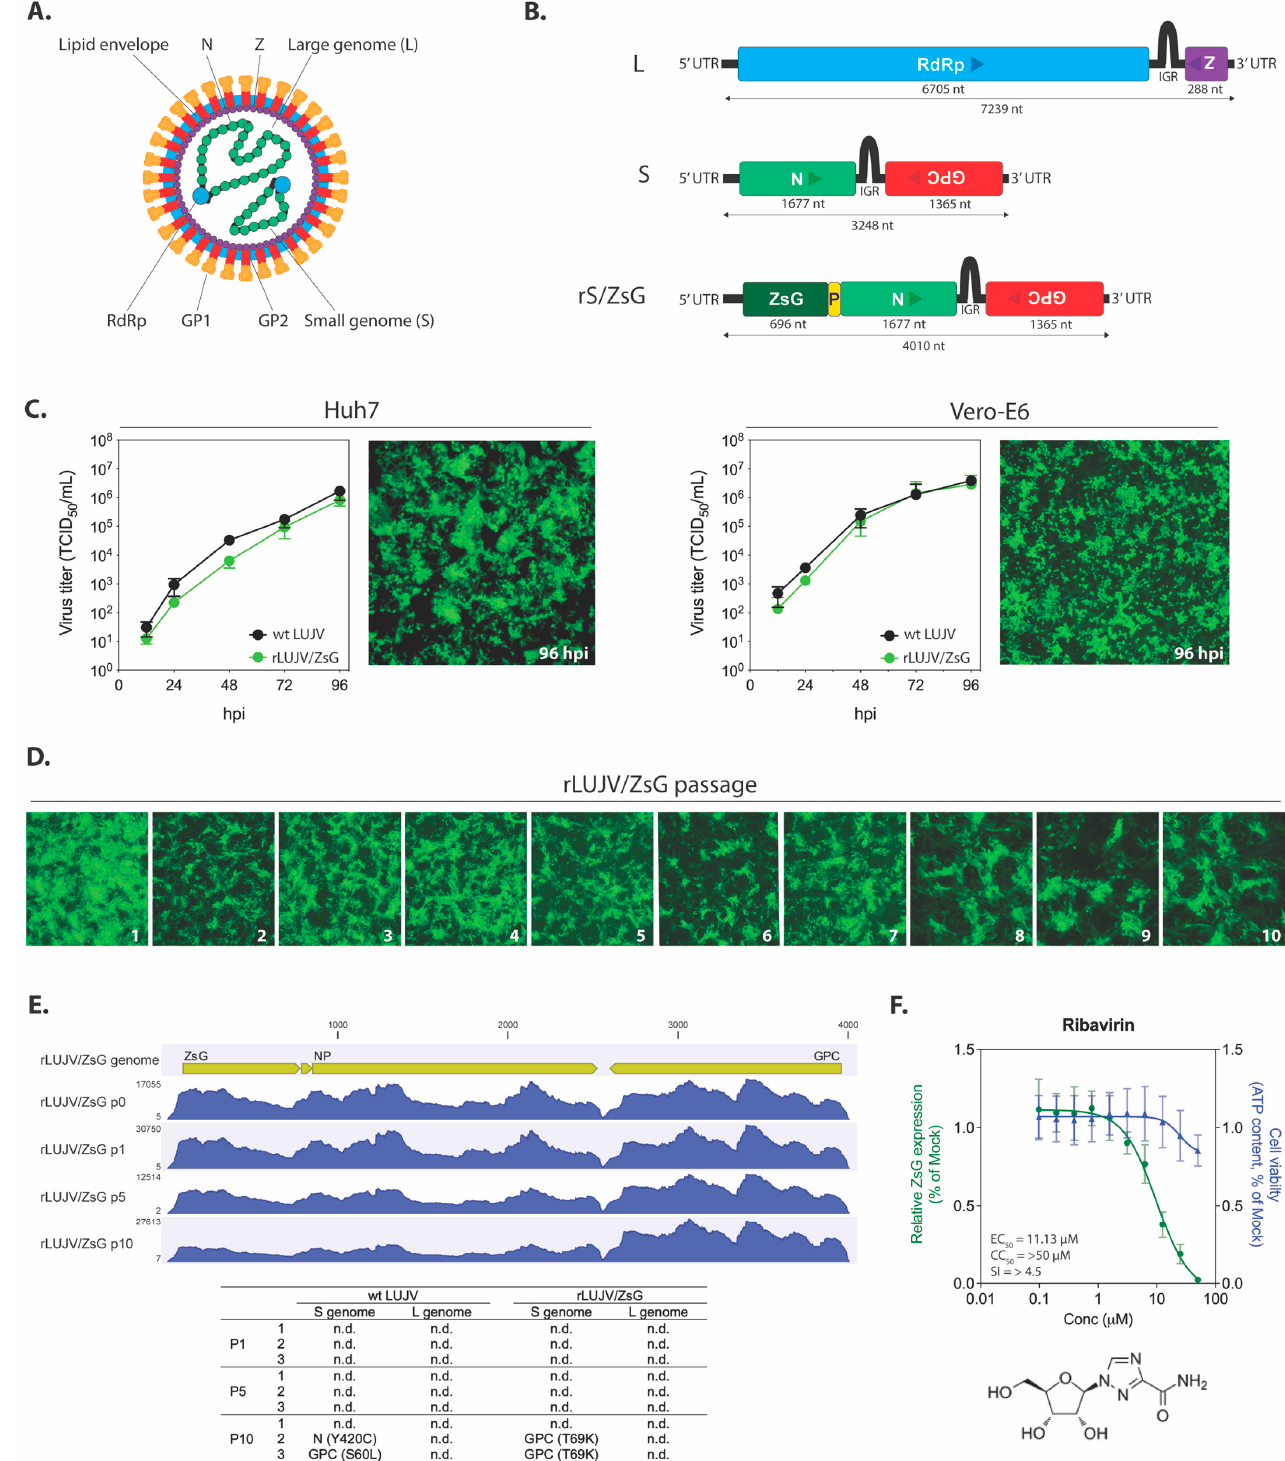
Figure 1. Design and characterization of rLUJV/ZsG. ( A ) Schematic representation of the Lujo virus (LUJV) virion; and ( B ) the LUJV large (L) and small (S) genome segments (antigenomic sense). Boxes represent the viral protein coding sequences (CDS) for RNA-dependent RNA polymerase (RdRp), Z matrix protein (Z), glycoprotein precursor (GPC), and nucleoprotein (N). Arrows represent the coding direction. The recombinant S genome segment (rS/ZsG) contains the ZsGreen1 (ZsG) CDS attached to the N CDS via a porcine teshovirus-1 2A (P2A; P in the figure) nucleotide sequence. GP1, glycoprotein 1; GP2, glycoprotein 2; UTR, untranslated region; IGR, intergenic region; nt, nucleotides. ( C ) Viral growth curves in Vero-E6 and Huh7 cells infected with either wild-type (wt) LUJV or rLUJV/ZsG at MOI 0.1. TCID 50 titers were determined at 12, 24, 48, 72,